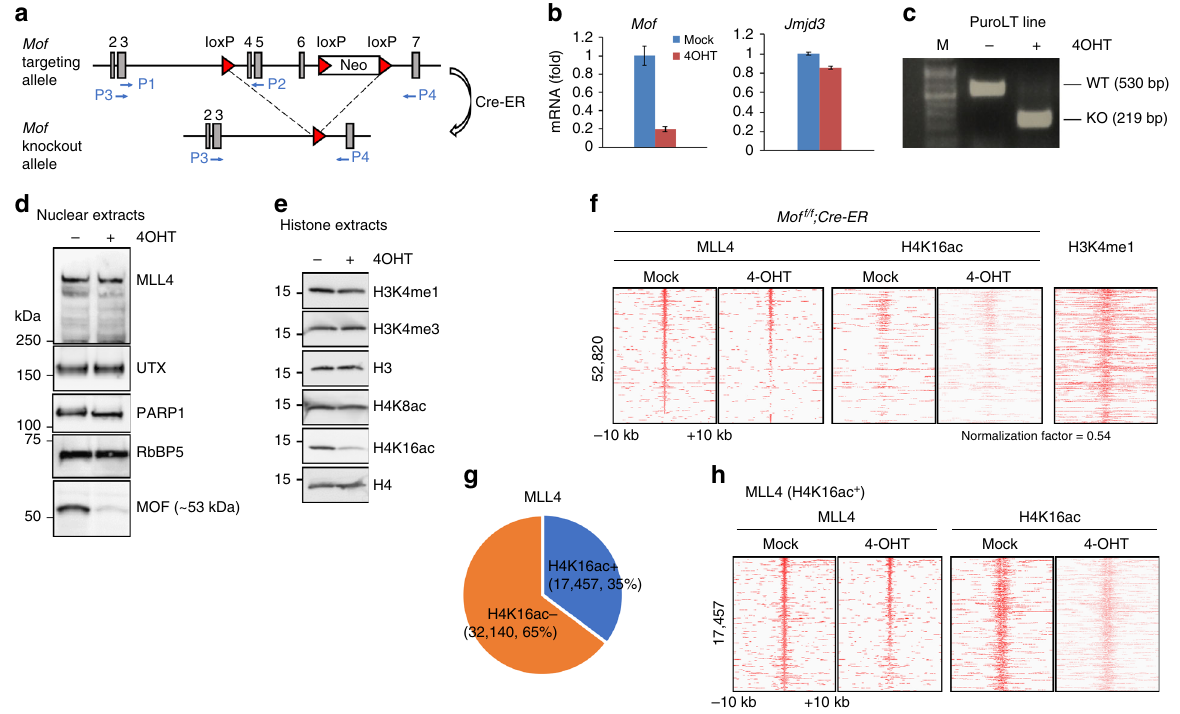
Fig. 4 A subset of MLL4-bound genomic regions overlaps with H4K16ac. SV40T-immortalized Mof f/f ; Cre-ER brown preadipocytes were treated with 4- hydroxytamoxifen to delete Mof . Cells were collected for reverse transcriptase PCR (RT-PCR), western blot and chromatin immunoprecipitation – sequencing (ChIP-Seq) analysis. a Schematics of targeting allele and knockout allele of Mof f/f mice. In the targeting allele, a single loxP site was inserted in the intron before exon 4 and a neomycin selection cassette fl anked by loxP sites was inserted in the intron after exon 6. The locations of RT-PCR primers P1 – P2 (used in Fig. 4b) and P3 – P4 (used in Fig. 4c) are indicated by arrows. b Quantitative RT-PCR con fi rmation of Mof deletion in preadipocytes. The data are presented as mean± s.d. Two technical replicates from a single experiment were performed. Source data are provided as a Source Data fi le. c RT-PCR con fi rmation of wild-type and truncated Mof mRNA. d Western blot analysis of MLL4, UTX, and MOF. PARP1 and RbBP5 were used as loading controls. e Western blot analysis of histone modi fi cations (also see Supplementary Fig. 15). f Heat maps around MLL4-binding sites. H4K16ac ChIP-Seq data were normalized